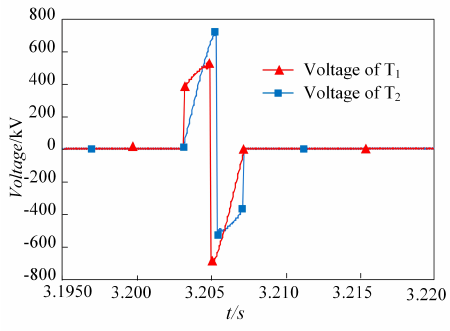
Fig. 10. T 1 , T 2 voltage waveform